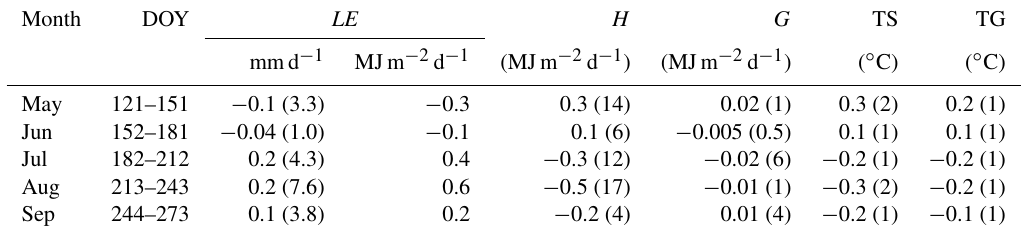
Table 8. Mean differences in latent heat flux ( LE ), sensible heat flux ( H ), ground heat flux ( G ), surface temperature (TS) and ground temperature (TG) between simulations with the LCC fraction increased by 10% and the baseline simulation (increased LCC share minus baseline simulation). Numbers in parentheses: the relative difference between increased LCC share and baseline simulation as a